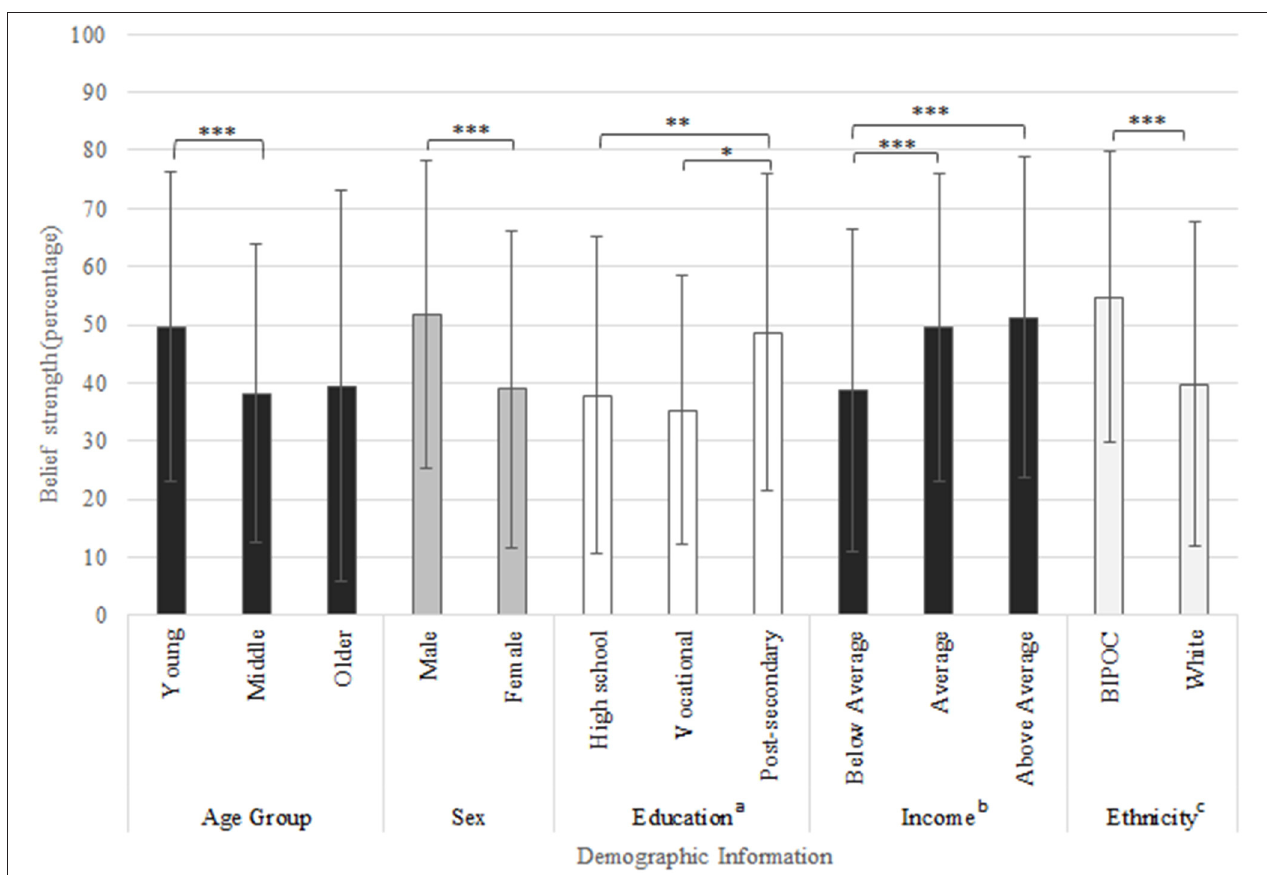
FIGURE 1 | Belief ratings (0–100%) based on question “to what extent do you believe that Alzheimer’s disease and dementia are preventable,” responses displayed by demographic subgroups. *Indicates p -value < 0.05, **indicates p -value < 0.01, ***indicates p -value < 0.001. Education was self-reported and categorized as follows: a high school education (some high school, high school diploma), vocational education (trade school or college diploma) and post-secondary education (bachelor’s or graduate degree). b Ethnicity was self-reported and categorized as follows: White and Black, Indigenous or Person of Color (BIPOC). c Other countries